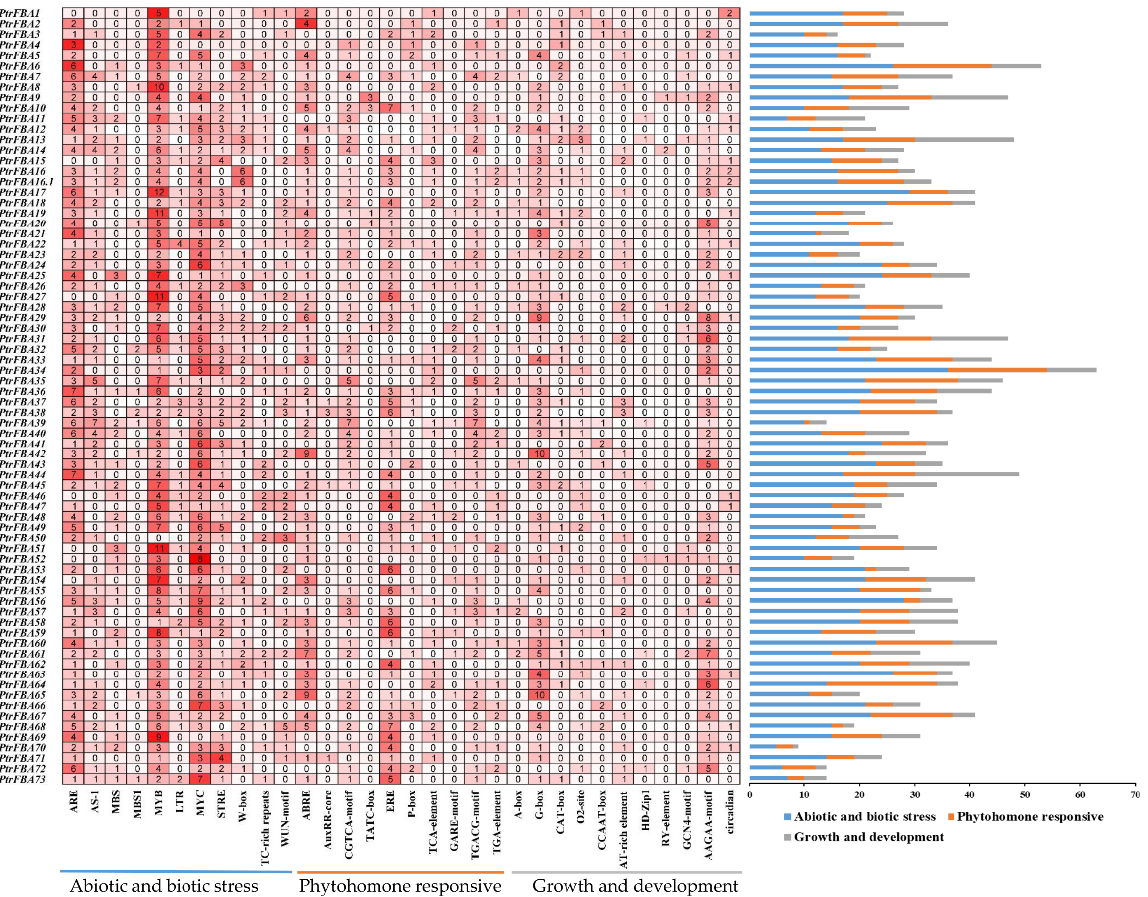
Figure 7. The cis-acting element of the PtFBA gene. Numbers and red gradient indicate the number of cis-acting elements. Color-coded histograms indicate the number of cis-acting elements for each type of gene, which are divided into the following three categories by functional factors: phytohormone responsive, abiotic and biotic stress, plant growth and development.